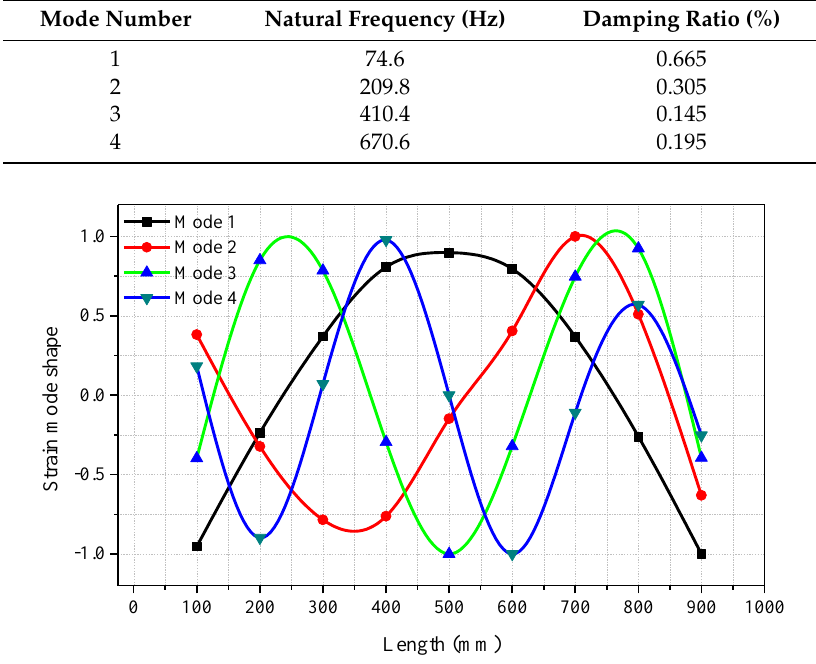
Figure 10. Normalised strain mode shapes along the length direction of the tested pipe.